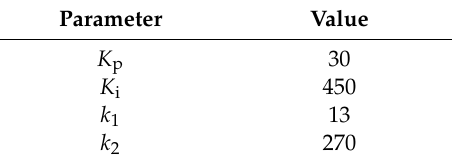
Table 2. Controller parameters.